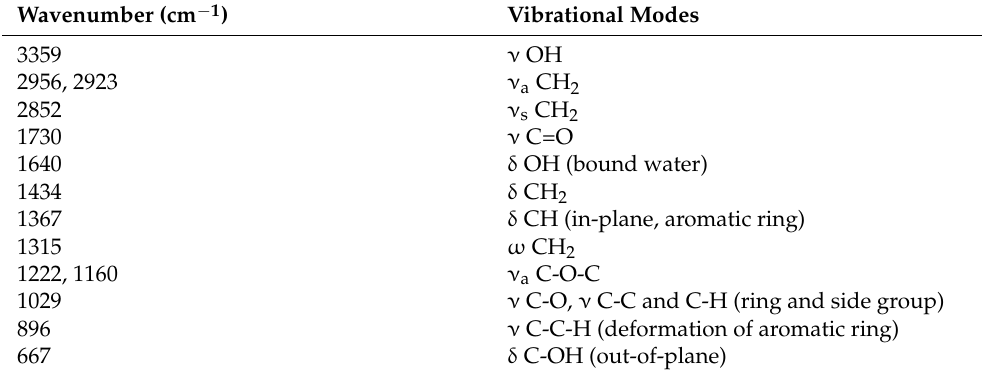
Table 3. Band assignment for the ATR-FTIR spectrum of sample P reported in Figure 6a.